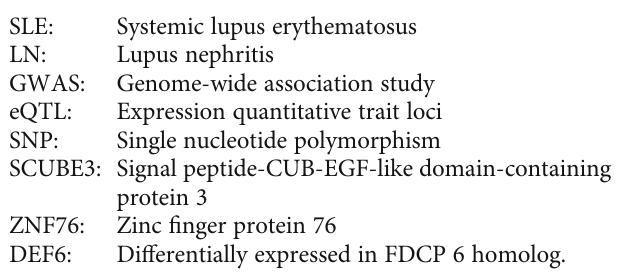
Supplementary Table 1. Association results of SNPs in SCUBE3 and SLE susceptibility.